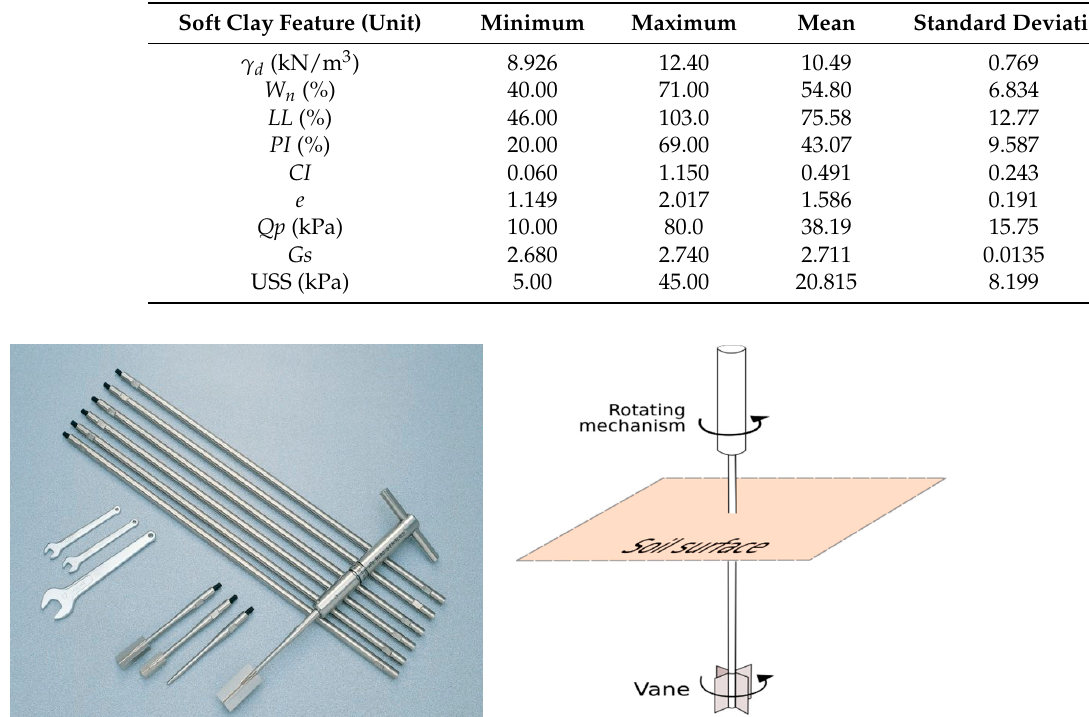
Figure 2. Field vane shear equipment.